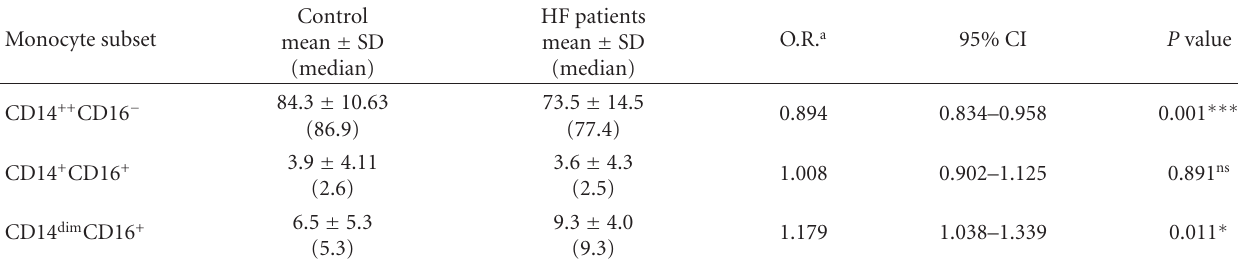
Table 2: Association between the three monocyte subsets and